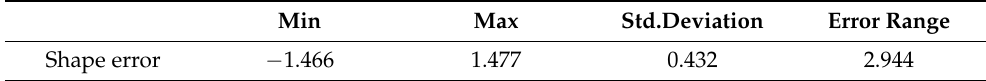
Table 4. Shape error of mold curve.